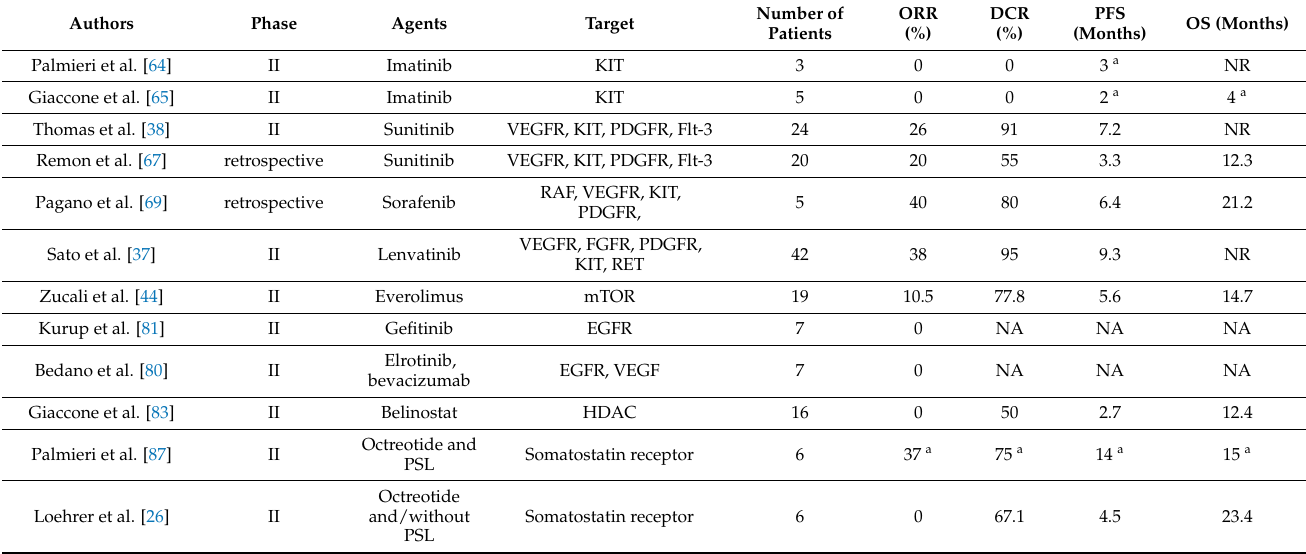
Table 1. The efficacy of targeted therapy for thymic carcinoma in clinical